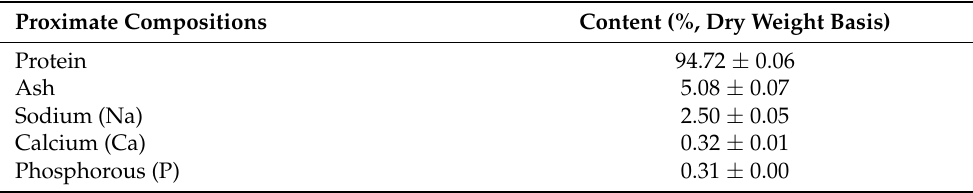
Table 5. Proximate compositions of hydrolyzed collagen powder defatted using DSCS for 9 cycles, followed by washing using isopropanol for 2 cycles (HC-C9/ISP2). Proximate